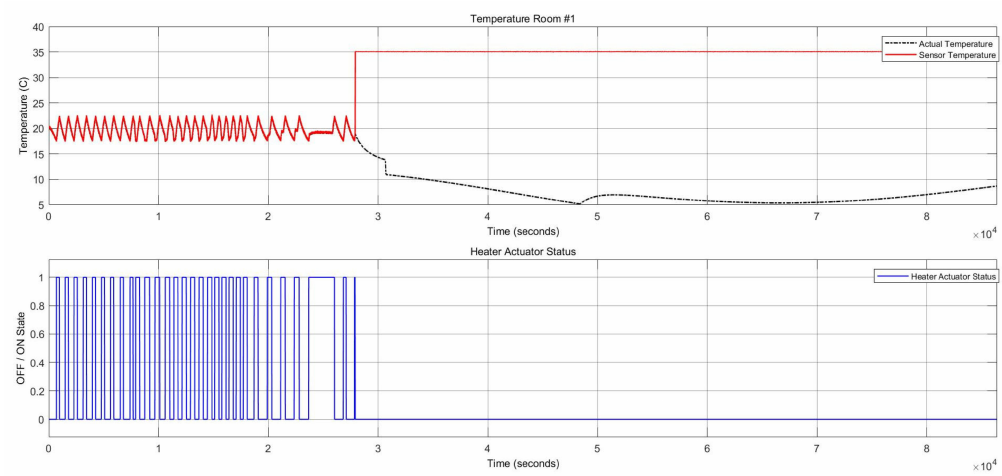
Figure 15. Thermal conditions and heater statuses for the damper actuator and temperature sensor faults.